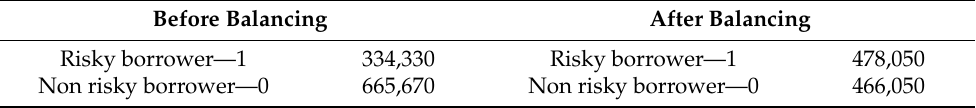
Table 4. Distribution without balancing and after balancing